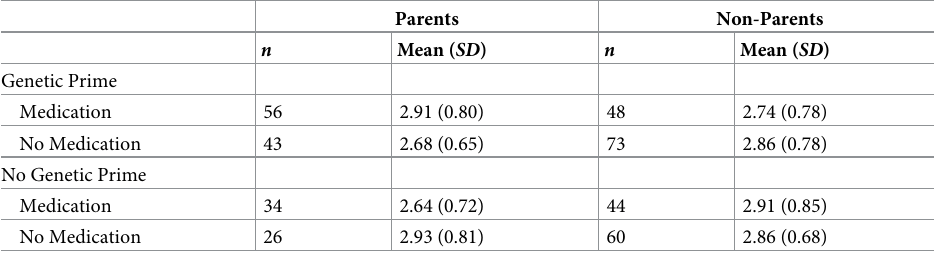
Table 1. Average composite stigma by etiology and treatment